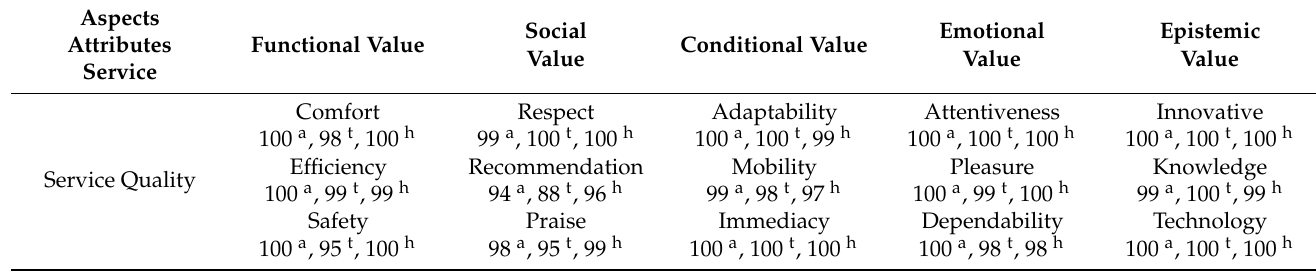
Table 7. Consistency data (%) on the universal applicability of the CV-SQ